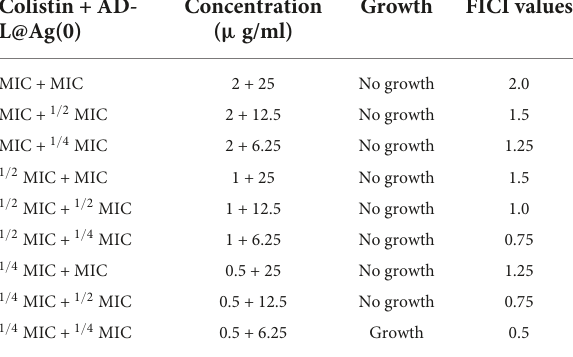
TABLE 1 Presence/absence of growth of AB in various combinations of MICs of Colistin + AD-L@Ag(0). Colistin + AD- L@Ag(0)